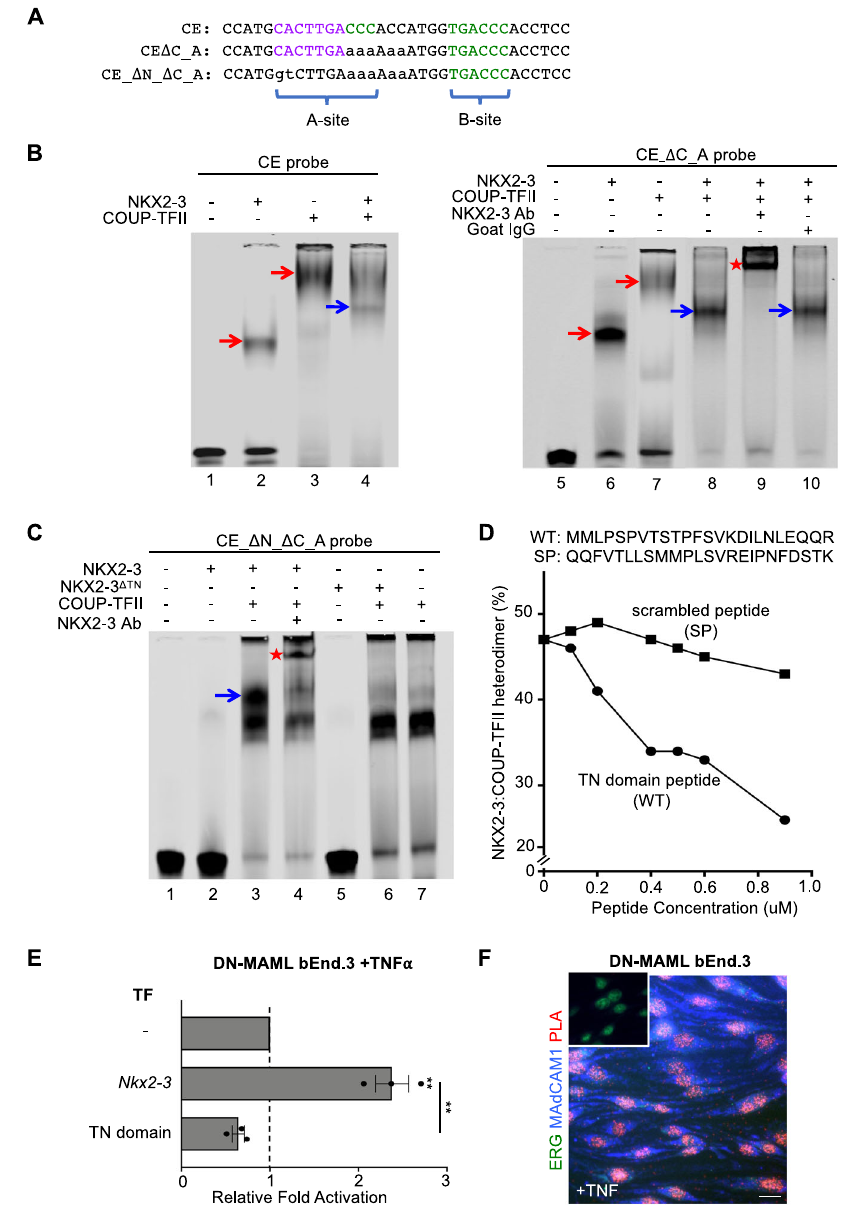
B EMSAshowingmigrationofrecombinantNKX2-3andCOUP-TFIIboundtotheCE probe (left) and to CE_ Δ C_A probe that lacks the COUP-TFII “ A ” site (right). Co- incubationof NKX2-3 and COUP-TFII yields a distinct band (blue arrows) re fl ecting an NKX2-3:COUP-TFII DNA complex that is supershifted by anti-NKX2-3 antibody butnotbycontrolantibody. C EMSAofproteincomplexesformedbyincubationof theindicatedTFswithamutantCEprobelackingtheNKX2-3andtheCOUP-TFII “ A ” binding sites (CE_ Δ N_ Δ C_A). The probe binds COUP-TFII (lane 7) and not NKX2-3 (lane 2), but seeds a COUP-TFII:NKX2-3:DNA complex (blue arrow) when co- incubated with both TFs. The heterodimer-DNA complex is supershifted by